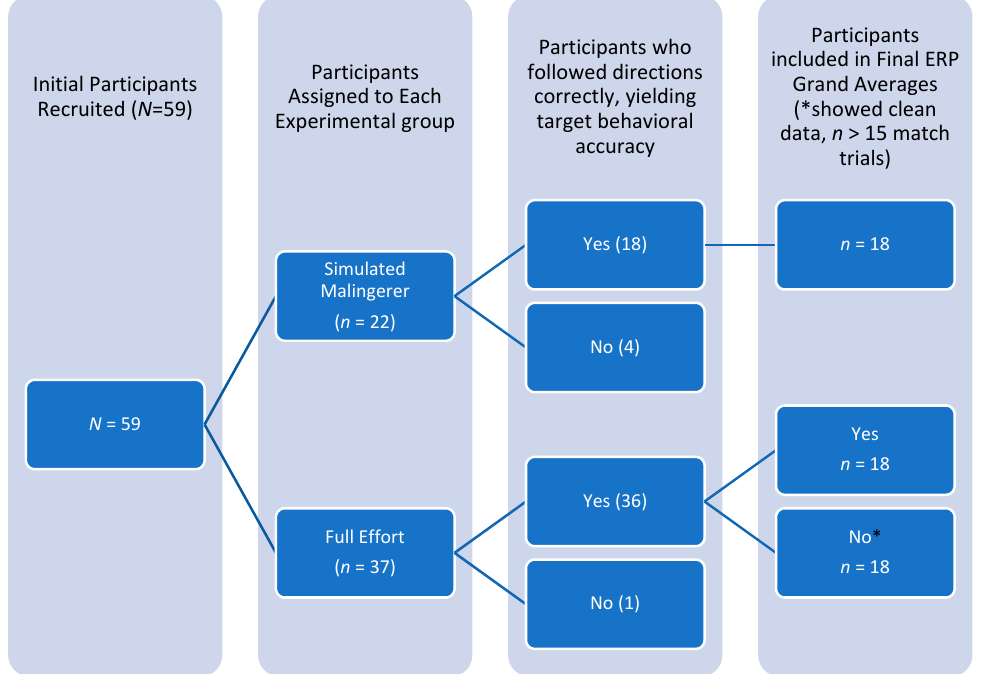
Figure 1. Study 1, Participant Recruitment Chart.